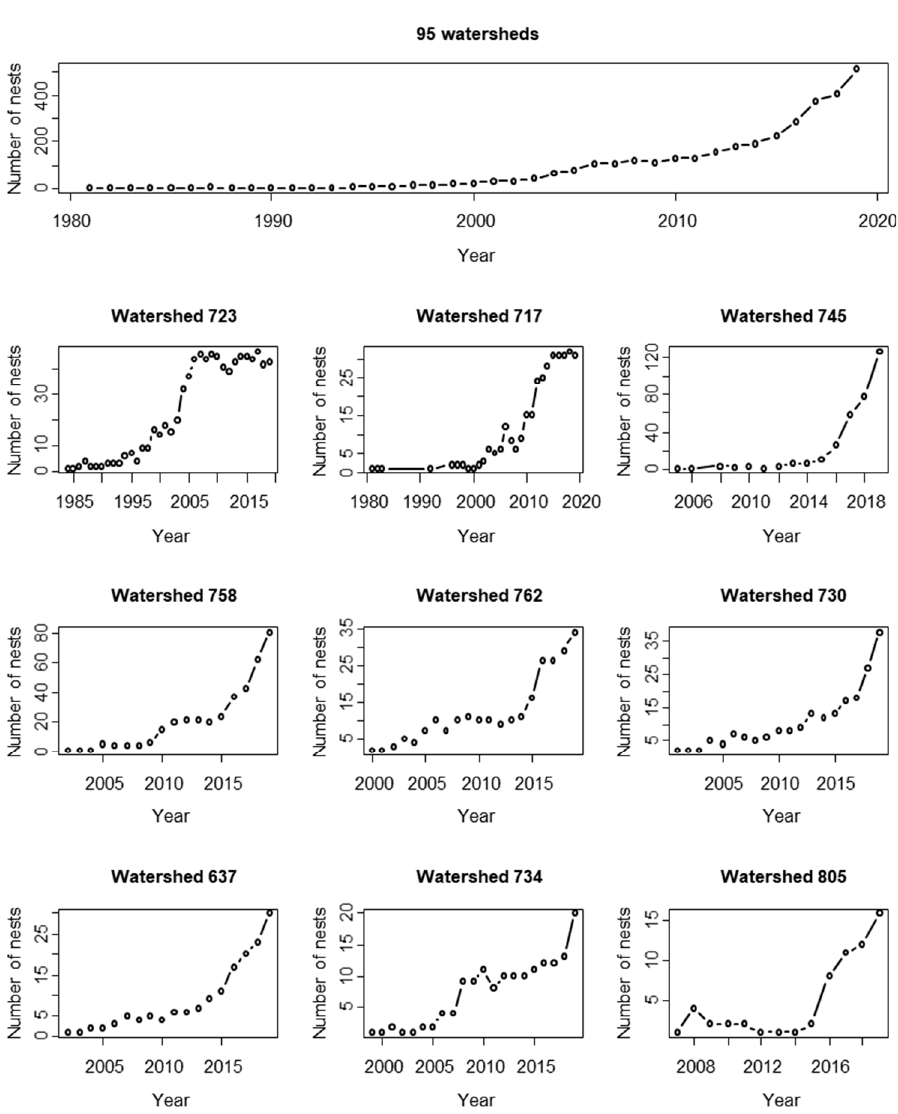
Figure 2. Number of nests of the crested ibis from 1981 to 2019 in its whole habitat (upper panel) and in the nine most occupied watersheds (lower panel).